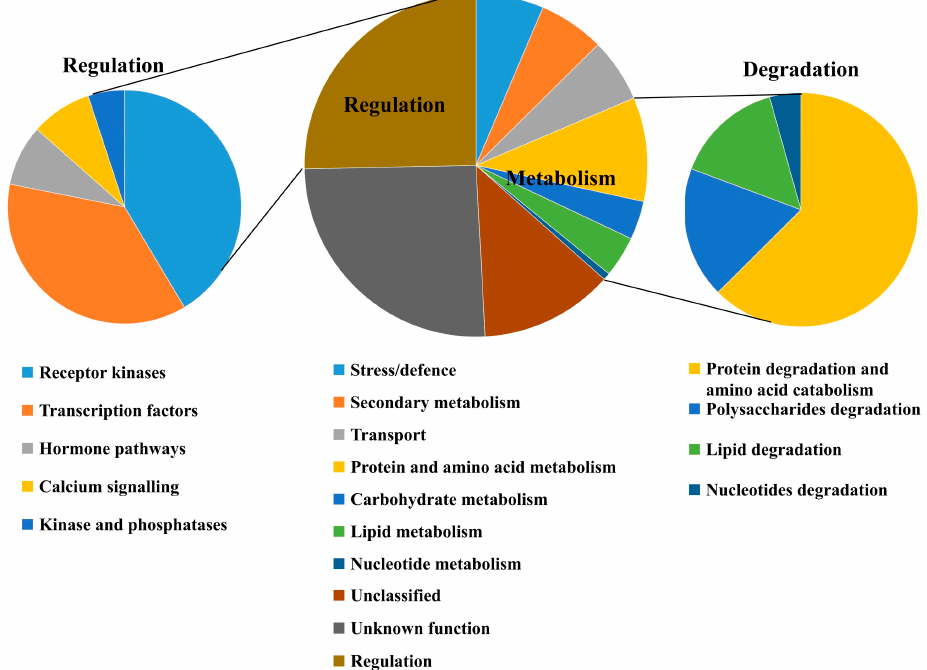
Figure 3. Potential functions of the DEGs between ptsd1 -YS and WT-YS. The groups are illustrated by the central pie chart with extra charts. Left chart indicates the genes encoding putative regulatory proteins. Right chart indicates the genes involved in macromolecule degradation of four major nutrients. The gene annotation information is listed in Table S7.